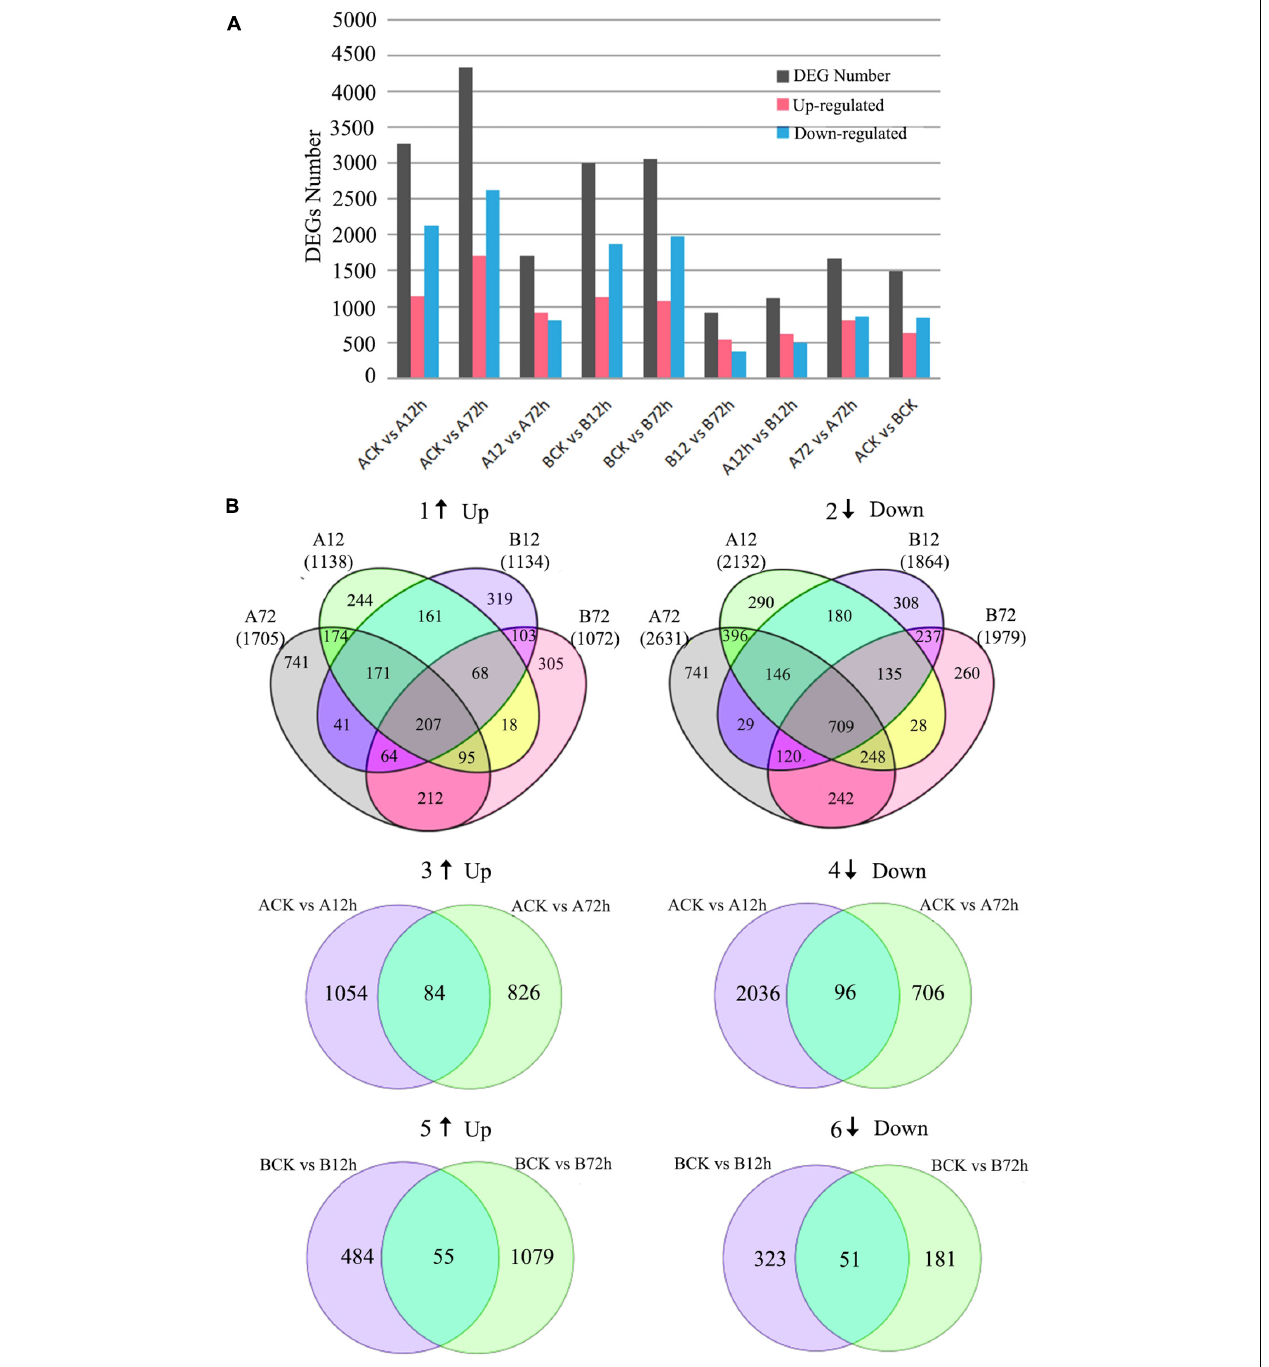
FIGURE 2 | Differentially expressed genes (DEGs) involved in fusarium oxysporum -treated melon materials “M4-45 and MR-1” at different time intervals. (A) Distribution of identified DEGs. (B) Venn diagrams of DEGs; numbers in parentheses represent the total number of upregulated or downregulated genes in each combination, 1, 3, and 5 indicate the upregulated genes expressions, and 2, 4, and 6 indicate downregulated expressions of